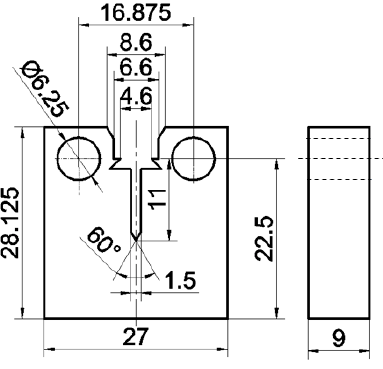
Figure 8. Size of the tensile test specimens.